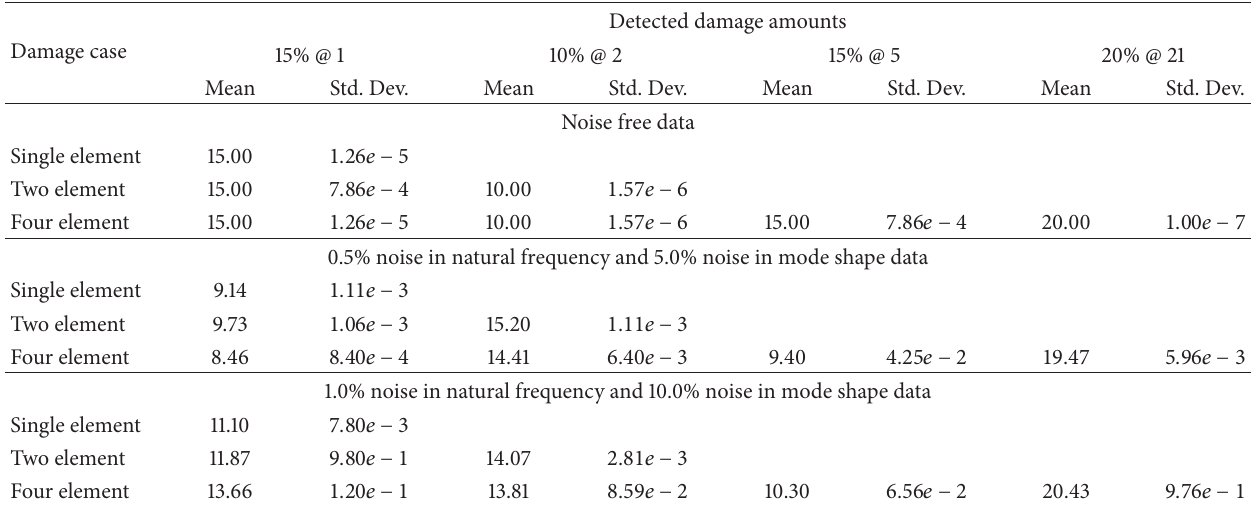
Table 9: Statistical results for damage detection in 3-bay and 4-storey frame structure.